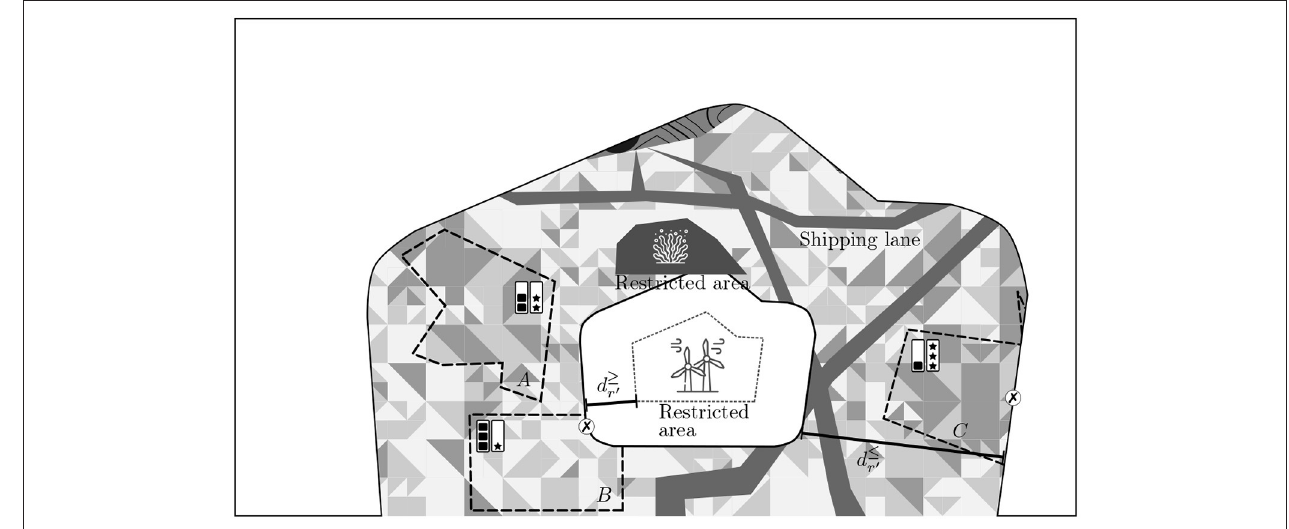
FIGURE 4 | Modification of the feasible region by the buffering technique.